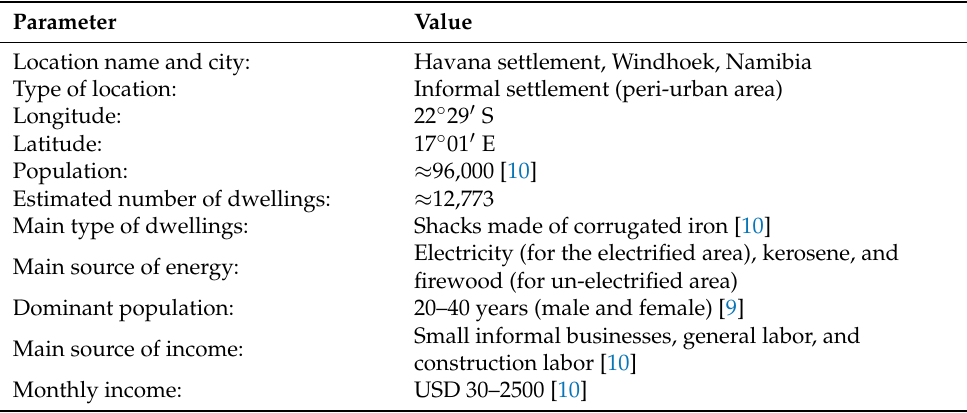
Table 3. Site parameters for Havana informal